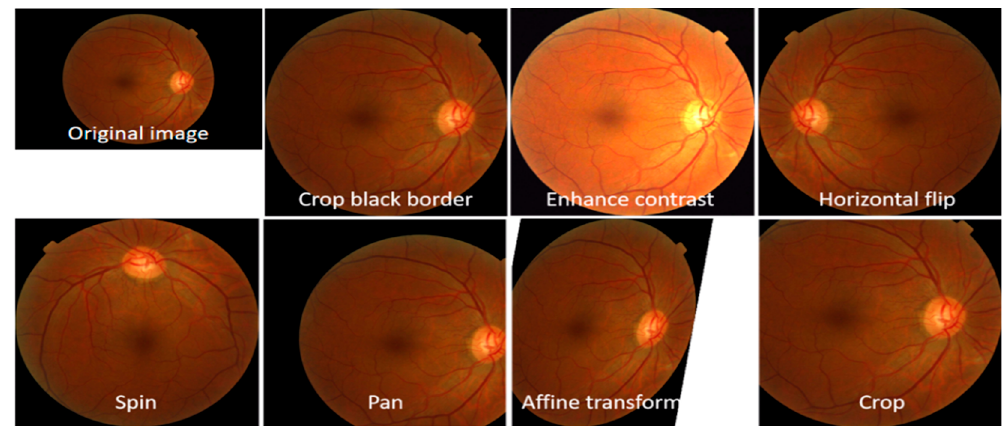
Figure 4. A visual example of the proposed data augmentation.